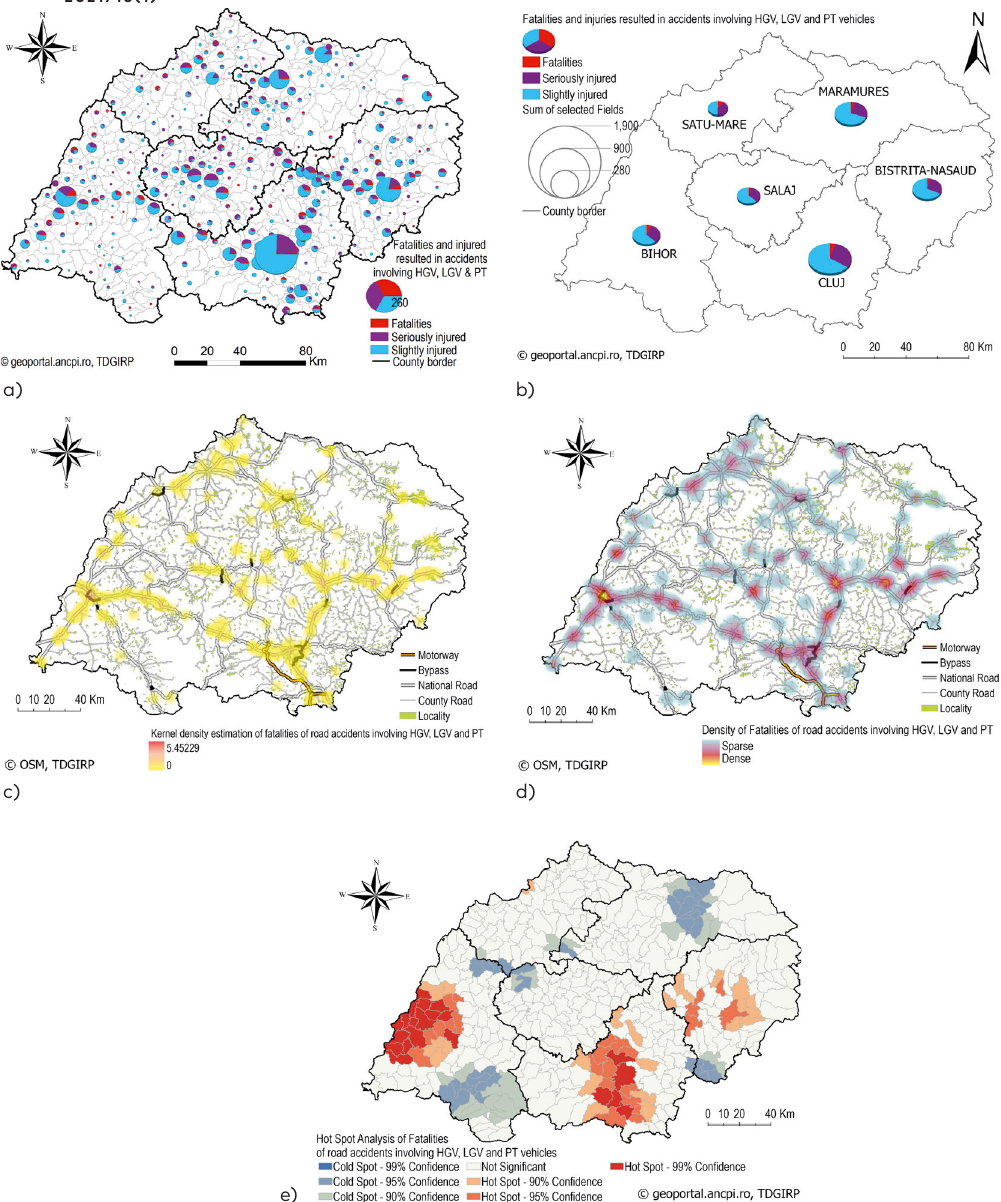
Figure 6. Victims of HGV, LGV and PT accidents in the N-W Region over the period between 2015 and 2018: a) fatalities, seriously injured and slightly injured summarized in the municipalities; b) fatalities, seriously injured and slightly injured summarized in the counties; c) fatalities heat